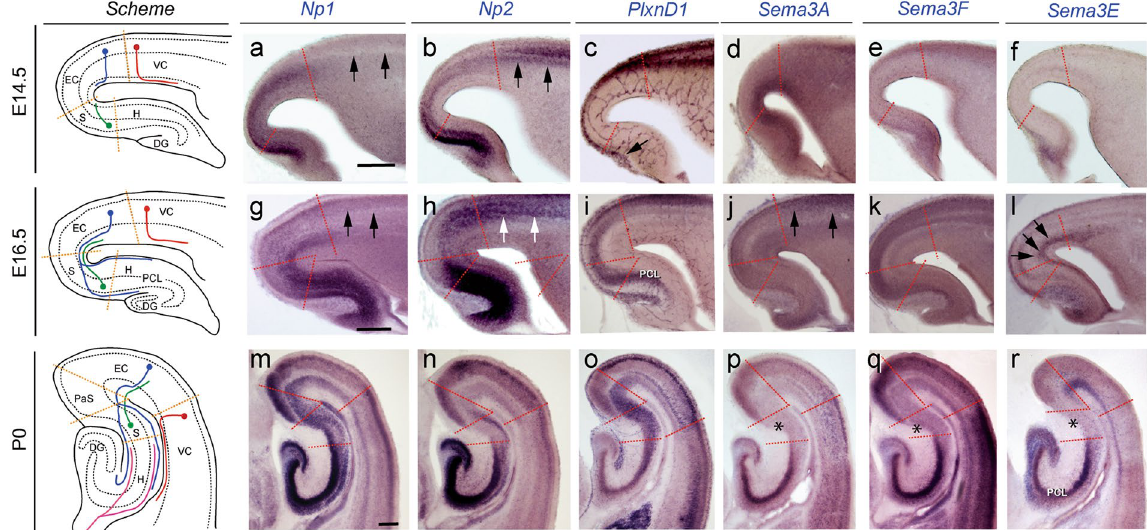
Figure 1. Low-power photomicrographs illustrating the distribution of Np1 ( a,g,m ); Np2 ( b,h,n ); PlnxD1 ( c,i,o ); Sema3A ( d,j,p ); Sema3F ( e,k,q ) and Sema3E ( f,l,r ) mRNA in the hippocampal formation and adjacent ventrolateral cortex at E14.5 ( a–f ), E16.5 ( g–l ) and P0 ( m–r ). The different regional boundaries are circumscribed by dashed lines. Characteristic corticofugal, entorhino-hippocampal, subiculo-entorhinal and commissural afferent connections are labelled in red, blue, green and pink respectively in the scheme. Note the absence of Np1 labelling in the ventrolateral cortex at E14.5 and E16.5 (arrows in a and g ), compared to Np2 (arrows in b and h ) and PlnxD1 ( c and i ). Sema3A levels in the ventrolateral neocortex were intense at E16.5 (arrows in j ). In addition, Sema3E levels in lower layers of both the ventrolateral and entorhinal cortices can be seen from E16.5 onwards (arrows in l ). Surprisingly, the subicular region was almost absent of semaphorin labelling (asterisk in p – r ). Abbreviations: DG = dentate gyrus; EC = entorhinal cortex; H = hippocampus proper; PaS = parasubiculum; PCL = pyramidal cell layer; S = subiculum; VC = ventrolateral neocortex. Scale bars: a = 250 μ m pertains to ( b – f ); g = 250 μ m pertains to ( h – l ) and m = 100 μ m pertains to ( n – r ).